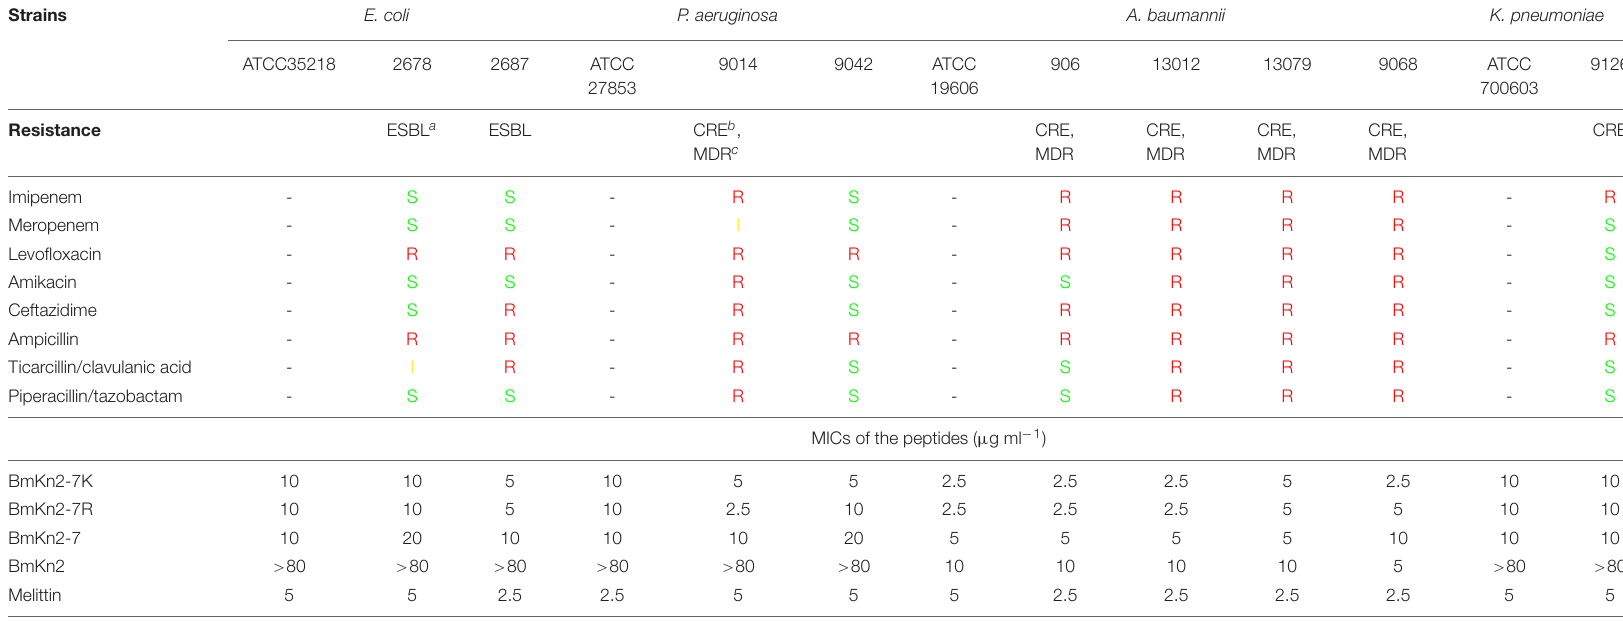
TABLE 4 | Minimum inhibitory concentrations of BmKn2-7K against clinically isolated gram-negative bacteria.